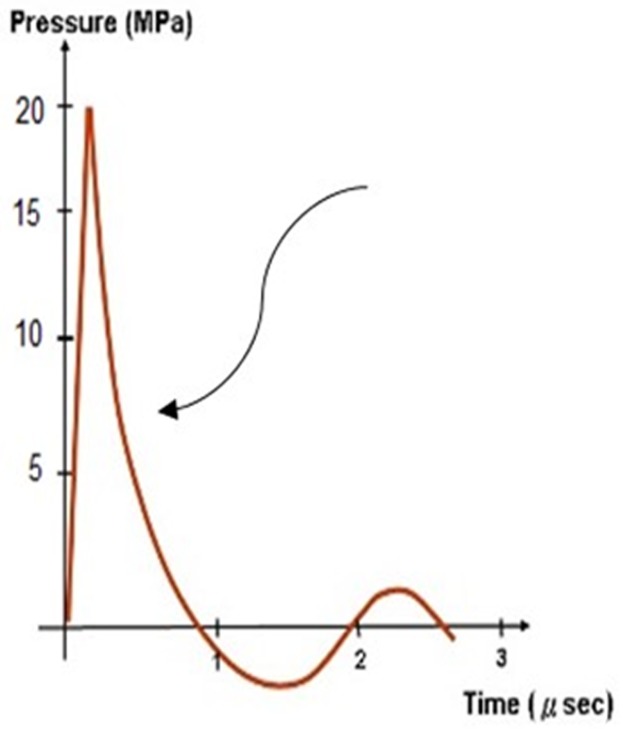
Acoustic pulse.A typical acoustic pulse in the treated area.